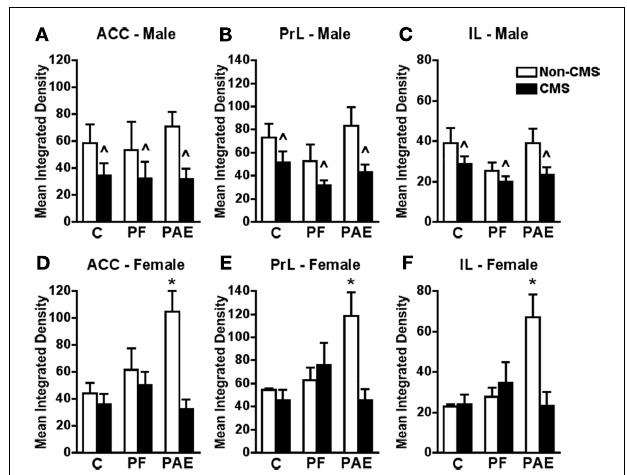
FIGURE 3 | Medial prefrontal cortex c-fos mRNA expression in response to the elevated plus maze test in male and female control (C), pair-fed (PF), and prenatal alcohol exposed (PAE) rats, with or without exposure to chronic mild stress (CMS) in adulthood . Bars represent the integrated density (mean ± SEM) of c-fos mRNA expression in the ACC (A,D) , PrL (B,E) , and IL (C,F) . *Indicates a significant interaction between prenatal treatment and CMS exposure where the PAE non-CMS group is different from all other groups; ∧ indicates a significant main effect of CMS exposure ( n = 4–5 for all groups).